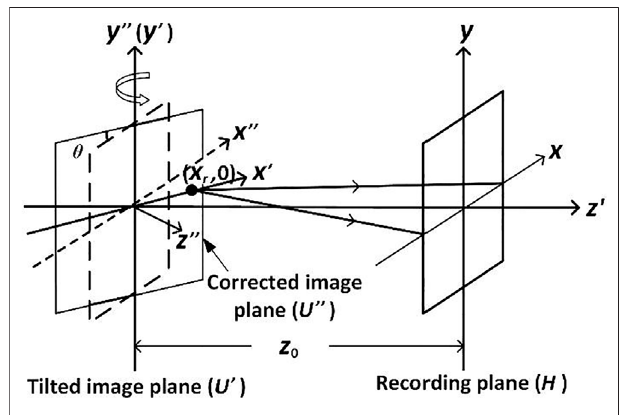
FIGURE 2 | Schematic of the correction to the tilted reconstructed image under tilted